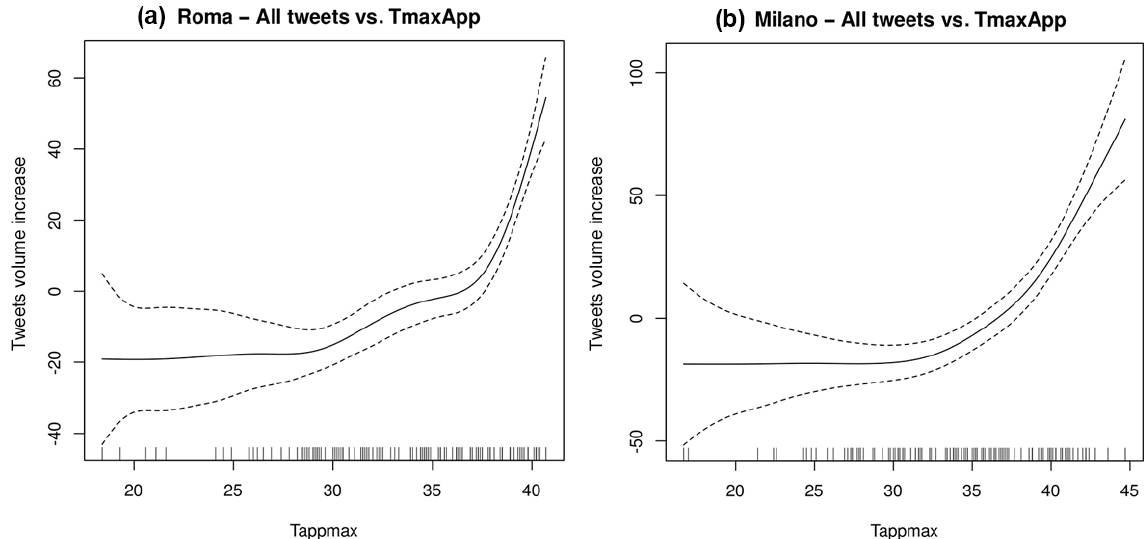
Figure 5. GAM Predicted daily Tweets volumes by Maximum Apparent Temperatures as a function of the x axis in Milan (b) and Rome (a) . Values are centered on